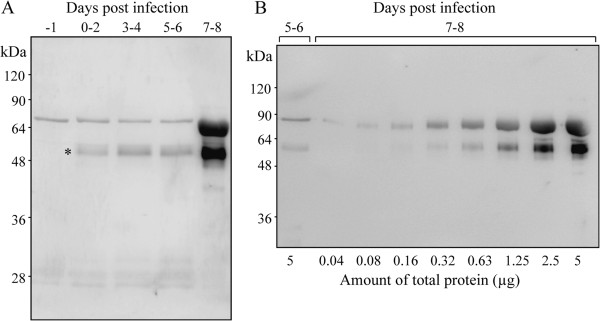
Immunoblotting of infected hamster urine by anti-HADH antisera. (A) Rabbit anti-rHADH serum was able to detect the 52 kDa protein (*) in the urine of infected hamsters (n = 3). Each lane contained 5 μg of protein. (B) It was revealed, by serial dilution of urine, that HADH increased in the said specimen during the seventh day post infection. These experiments were repeated three times, and the representative data are shown in this figure.